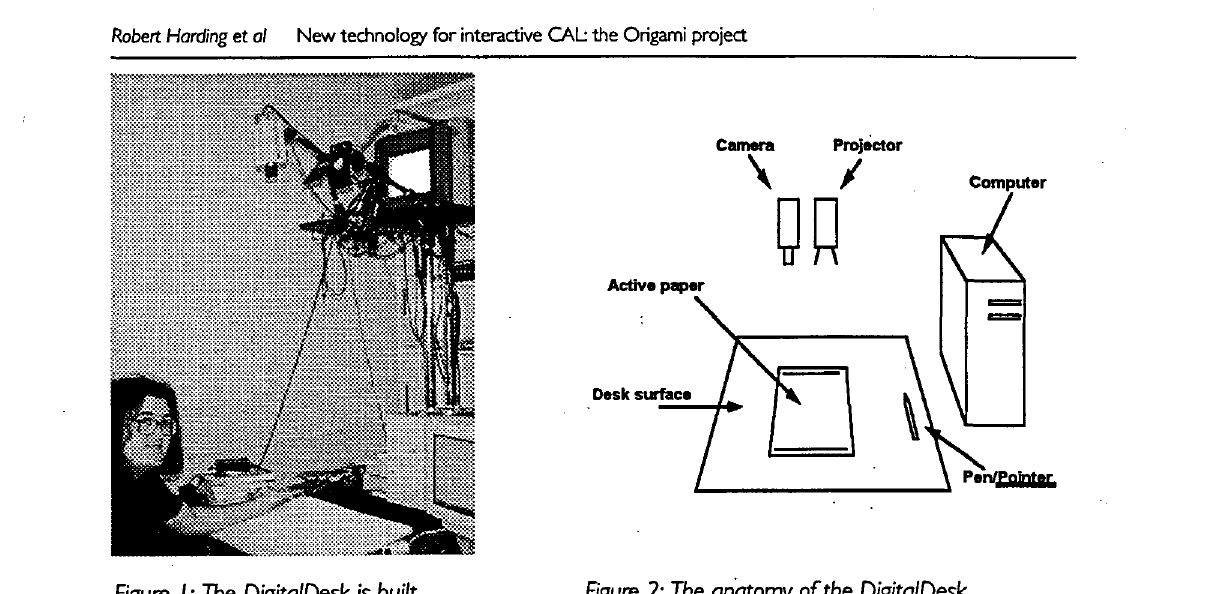
figure /: The DigitalDesk is built figure 2: The anatomy of trie